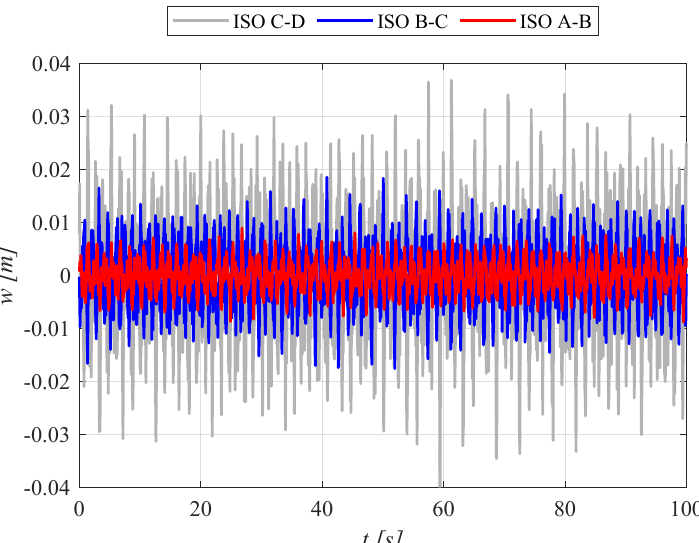
Figure 7. Time courses of excitation due to road irregularities generated according to [31] at a constant driving speed of 60